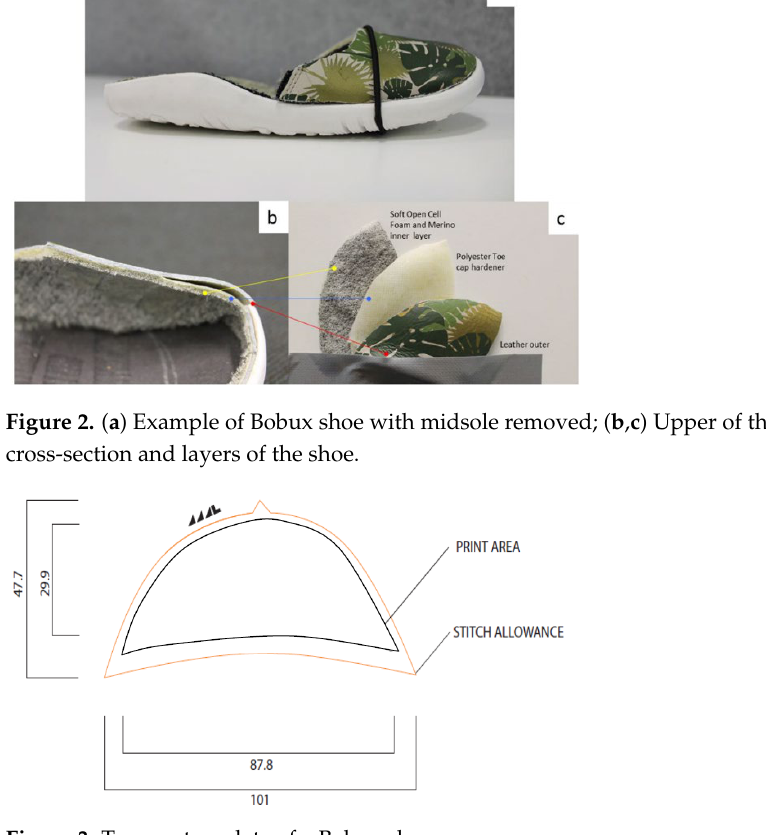
Figure 3. Toe-cap template of a Bobux shoe.